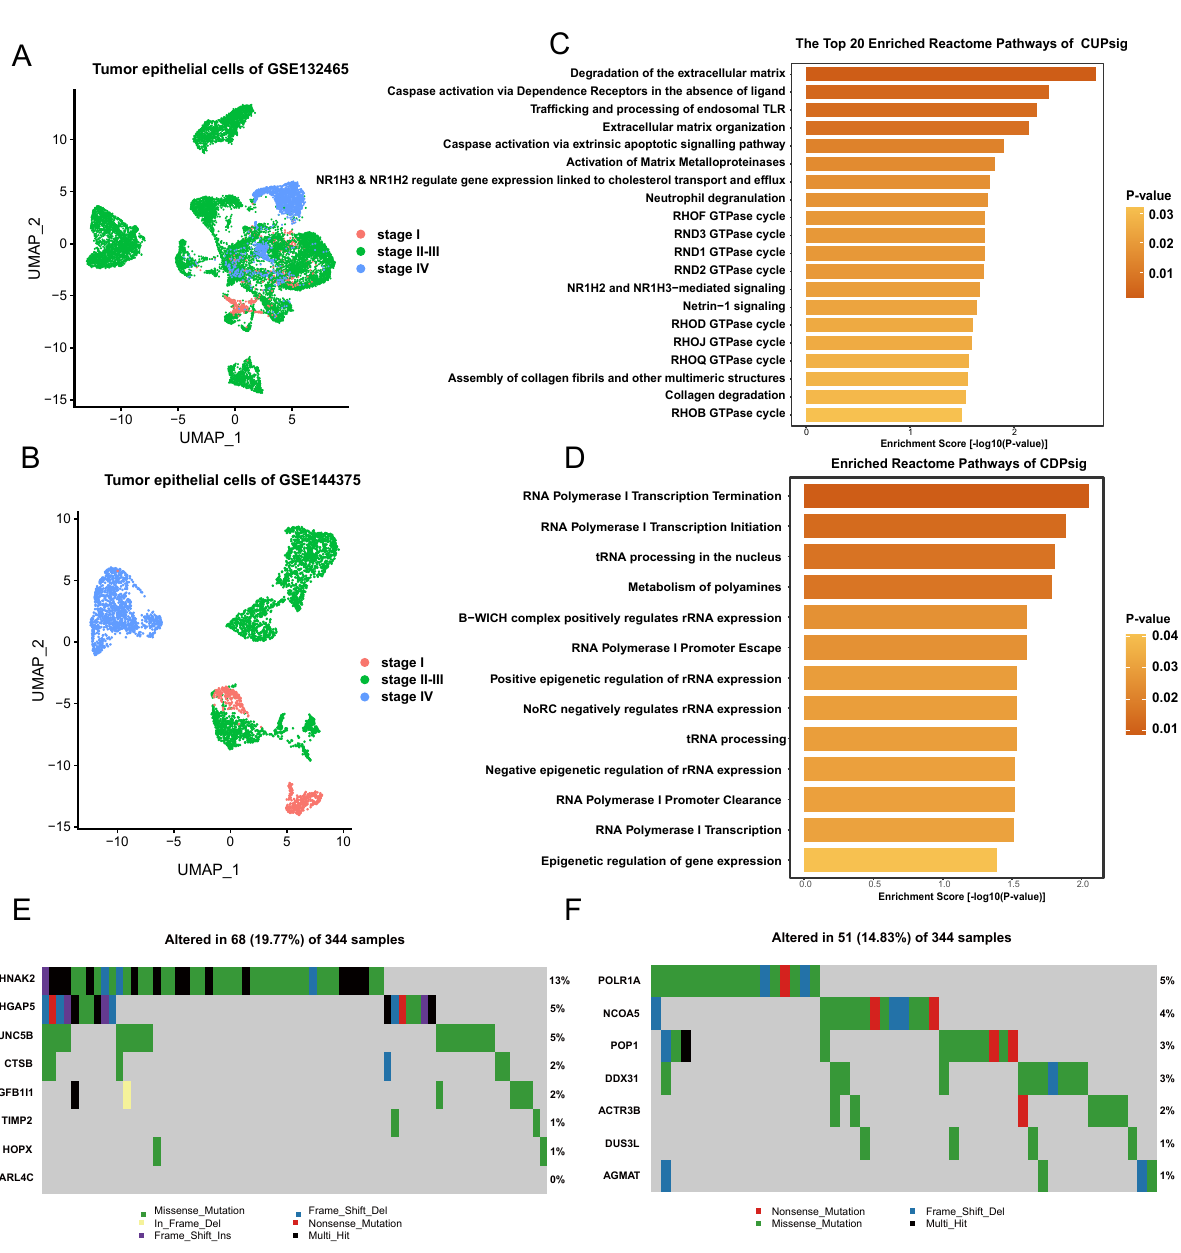
Figure 2. ( A , B ) UMAP plots of tumor epithelial cells in stage I, stage II–III, and stage IV of scRNA-seq datasets: ( A ) GSE132465, ( B ) GSE144735. ( C , D ) Results of Reactome enrichment analysis for CUPsig and CDPsig: ( C ) CUPsig, ( D ) CDPsig. ( E , F ) The mutation analysis of CUPsig and CDPsig in TCGA stage II–III CRC samples: ( E ) CUPsig, ( F )